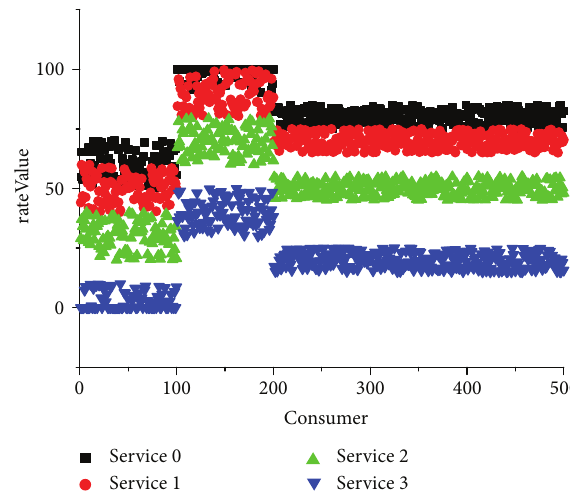
Figure 7: Ratings for four services given by 500 consumers.